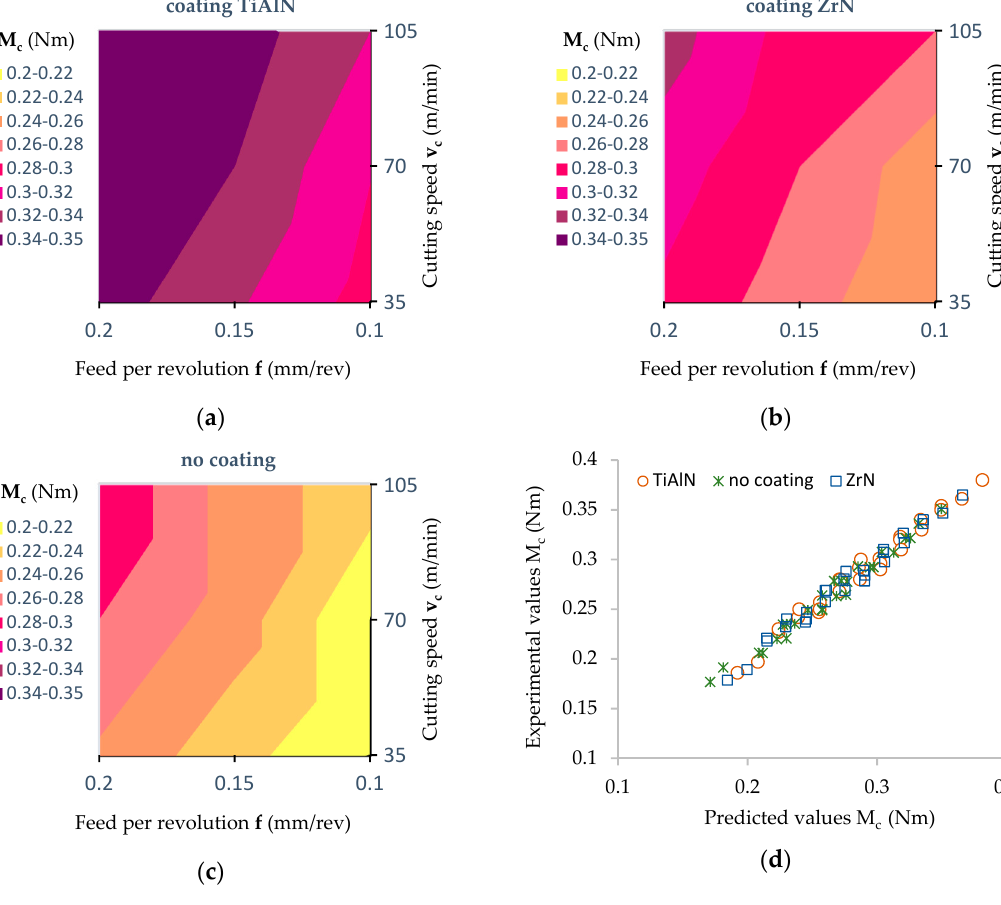
Figure 14. Influence of the feed value on the value of the cutting torque (contour diagrams): ( a ) For a TiAlN coated drill; ( b ) for a ZrN coated drill; ( c ) for an uncoated drill; ( d ) correlation between experimental and predicted values of cutting torque determined for the coated and uncoated tools.